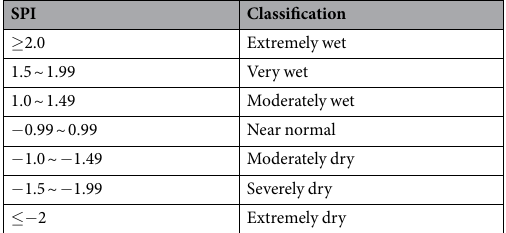
Table 7. Categories of drought grade based on